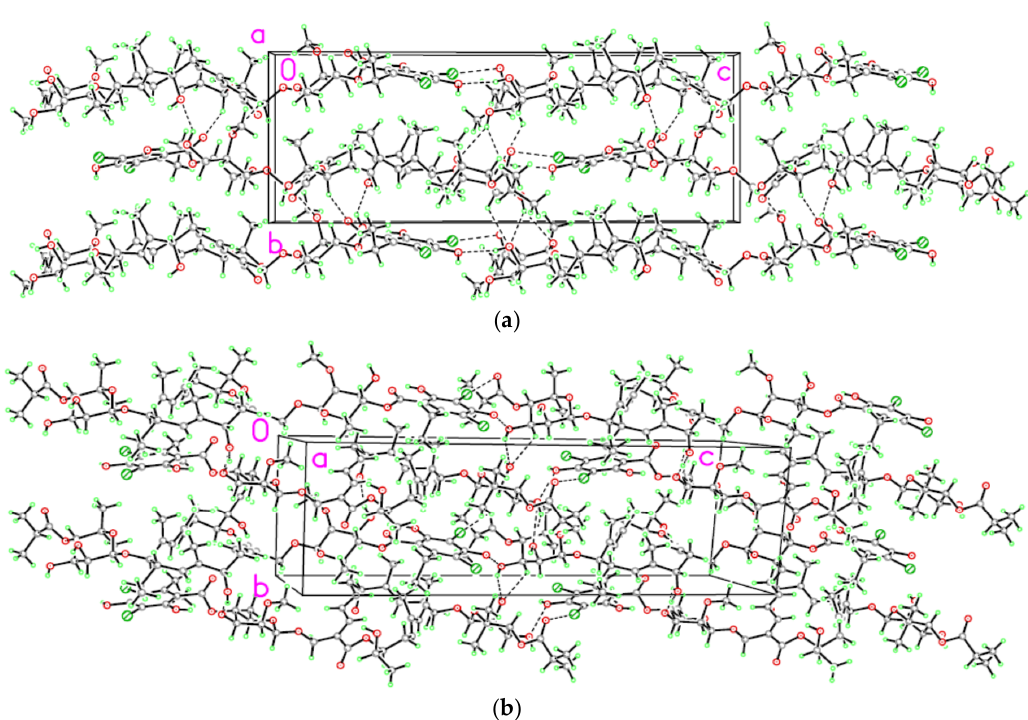
Figure 6. The molecular packing of the two fidaxomicin crystalline phases, viewed along the a axis: ( a ) monoclinic form; ( b ) triclinic form. Dashed lines indicate intermolecular halogen and hydrogen bonds.